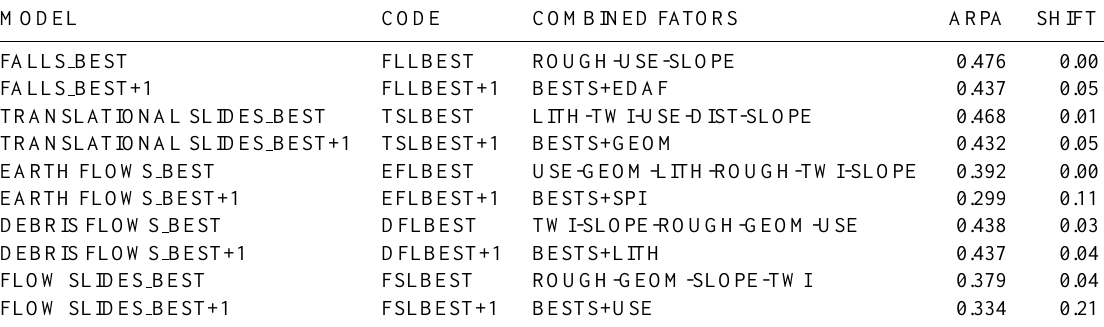
Table 5. Summary of the results of the validation of the suite of susceptibility models, for best and best+1. FLL: falls; TSL: Translation slides; EFL: Earth flows; DFL: Debris flows; FSL: Flow